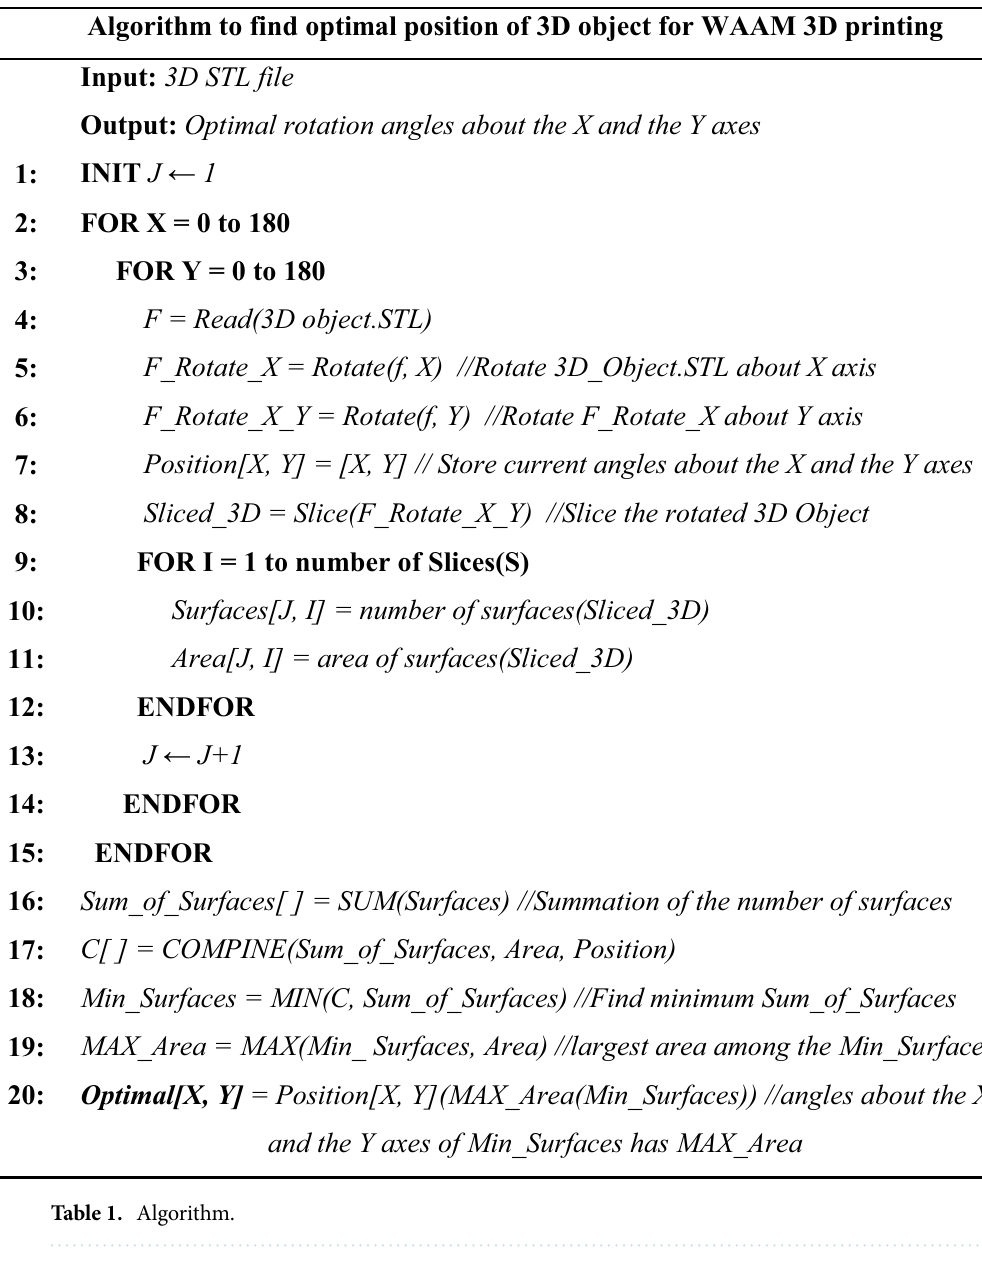
Algorithm to find optimal position of 3D object for WAAM 3D